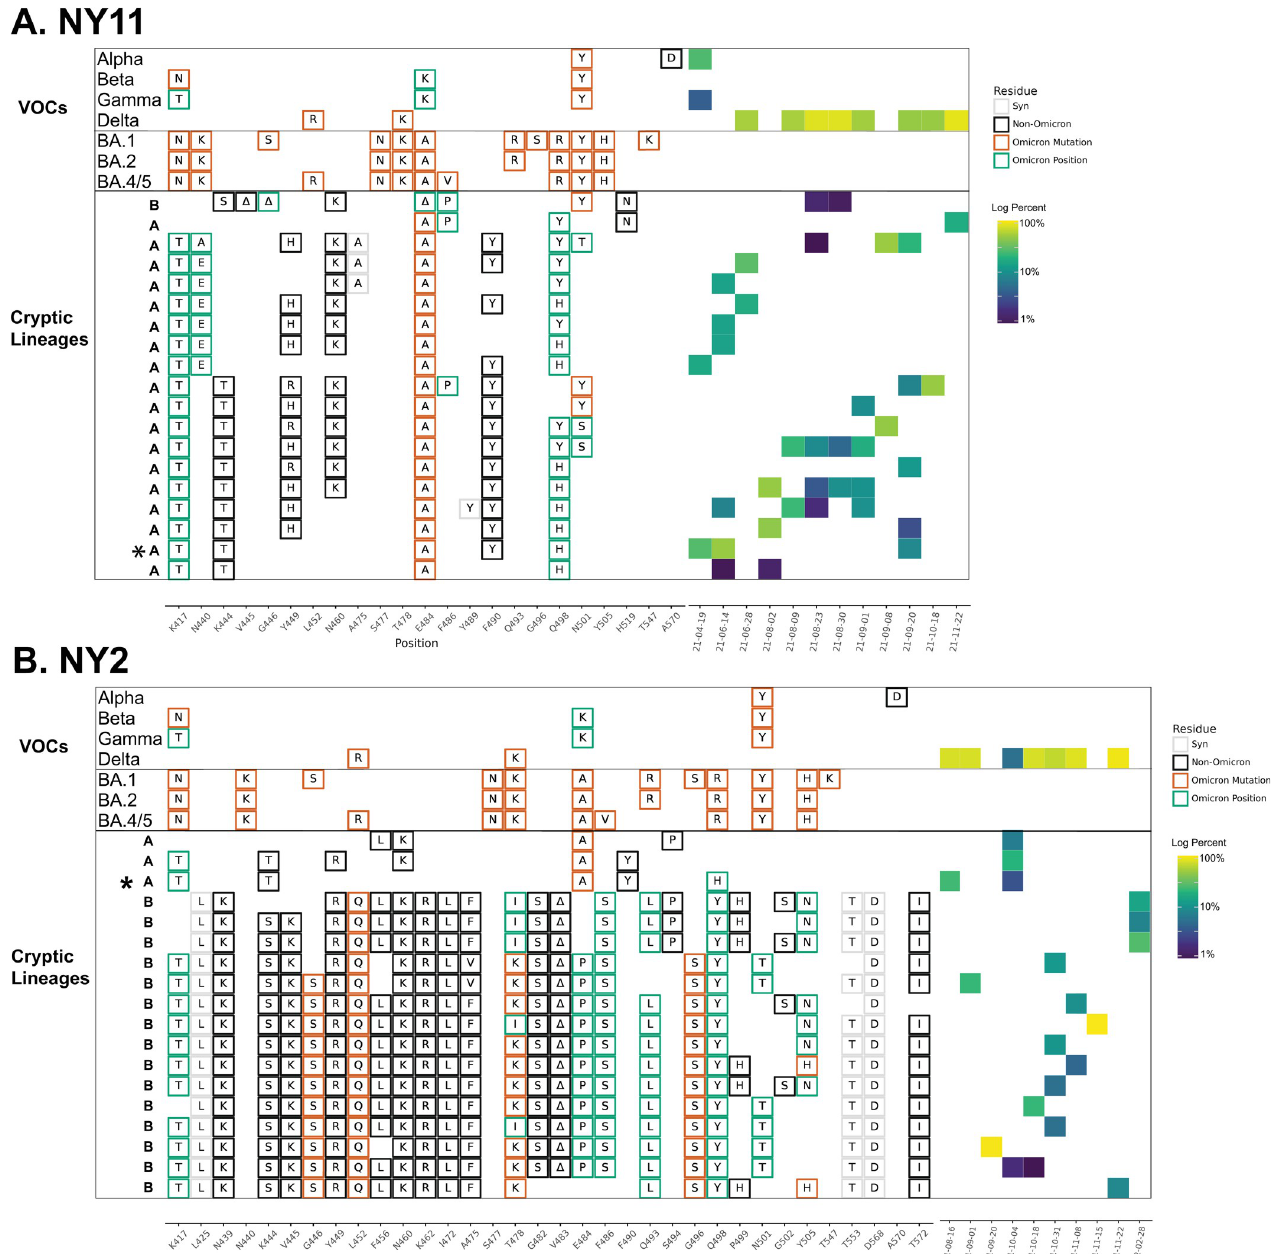
Fig 4. NY11 and NY2 RBD amplifications. Overview of the SARS-COV-2 Spike RBD lineages identified from the NY11 and NY2 sewershed. Lineages designated A and B belong to two lineages groups that appear unrelated. Amino acid changes similar to (green boxes) or identical to (orange boxes) changes in Omicron (BA.1, BA.2 or BA.5) are indicated. Synonymous changes (syn) are indicated in gray. The major VOCs during this time period (Alpha, Beta, Gamma, BA.1 and BA.2) are indicated. The heatmap (right) illustrates lineage (row) detection by date (column), colored by the log 10 percent relative abundance of that lineage. Lineage detected in both sewersheds indicated with an asterisk. Uncondensed output in S6 and S7 Data. https://doi.org/10.1371/journal.ppat.1010636.g004 Q498H/Y . Seven of the nine sewersheds in this study contained lineages with the amino acid change Q498H or Q498Y. It should be noted that Q498Y differs from the Wuhan ances- tral sequence by two nucleotide substitutions at the 498th codon (CAA ! TAC). Q498H (CAA ! CAC) is a necessary intermediary in this transition as TAA encodes a stop codon. In